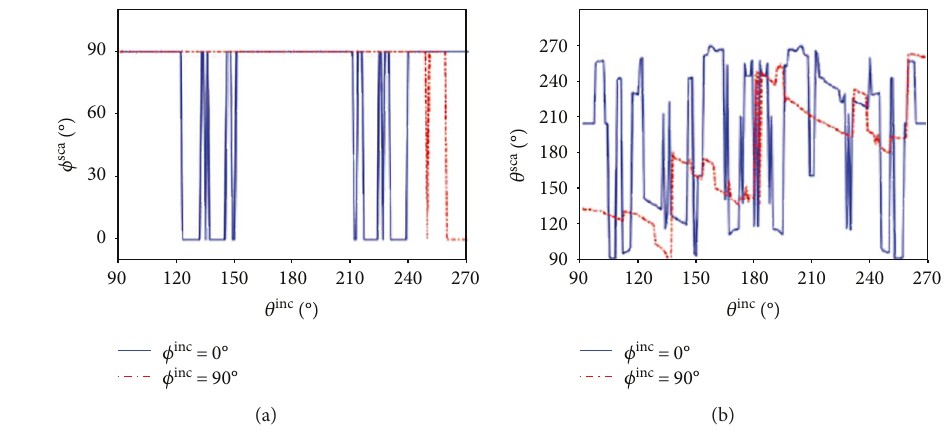
Figure 13: Direction of the minimum RCS ( α = 90 ).